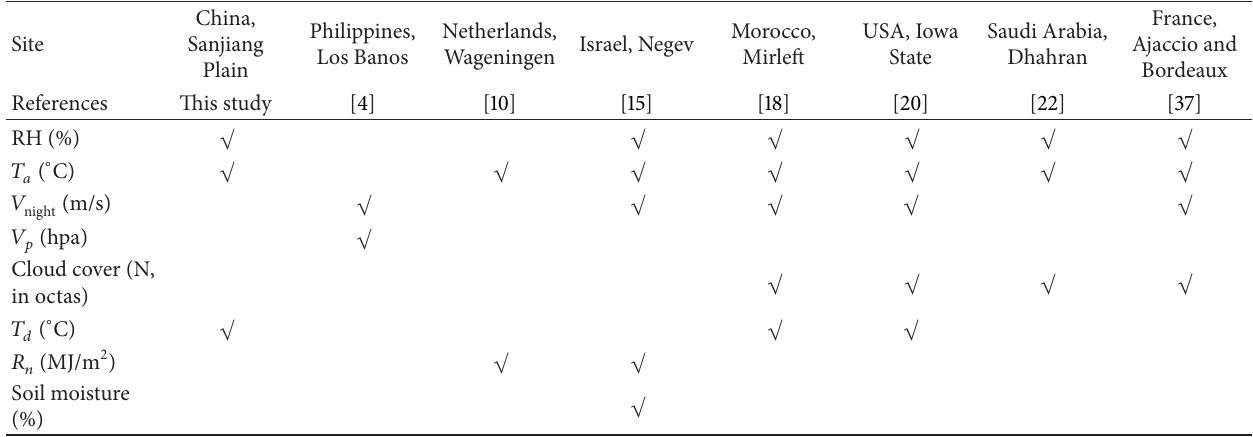
Table 5: Parameters in models at Sanjiang Plain and at reported